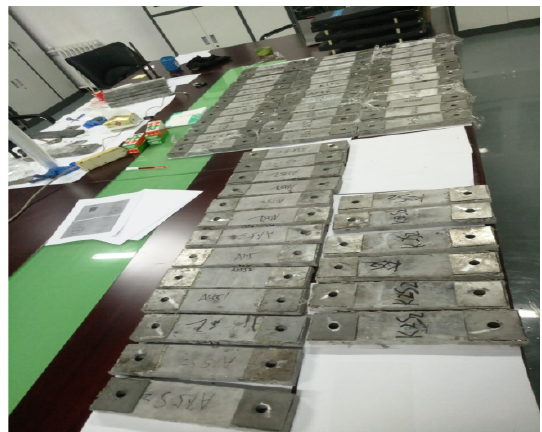
Figure 3. Specimens with the end reinforcement.